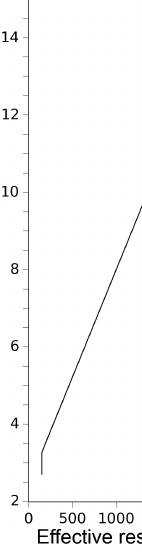
Figure 4. A plot showing the effective resolution of the DIAL ozone profiles. The MSL (mean sea level) scale was used during the SCOOP campaign, and the AGL (above ground level) scale was used for the Oski-ôtin